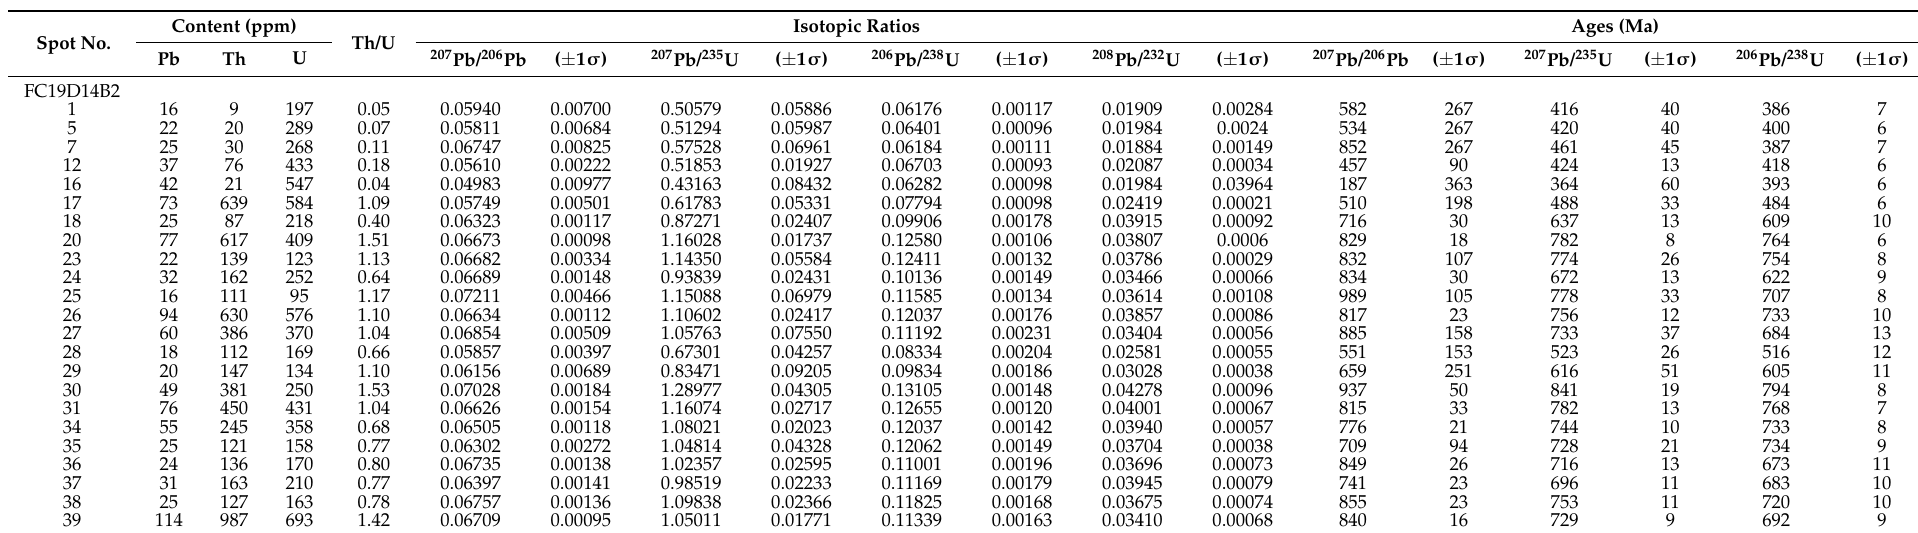
Table 2. LA–ICP–MS zircon U–Pb